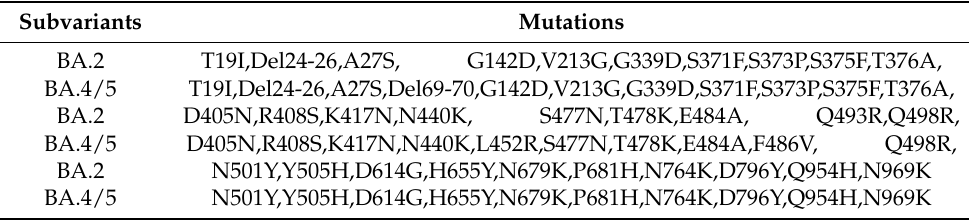
Table 2. Mutations in the spike protein of Omicron subvariants: BA.2 and BA.4/5. Subvariants Mutations BA.2 T19I,Del24-26,A27S, G142D,V213G,G339D,S371F,S373P,S375F,T376A,